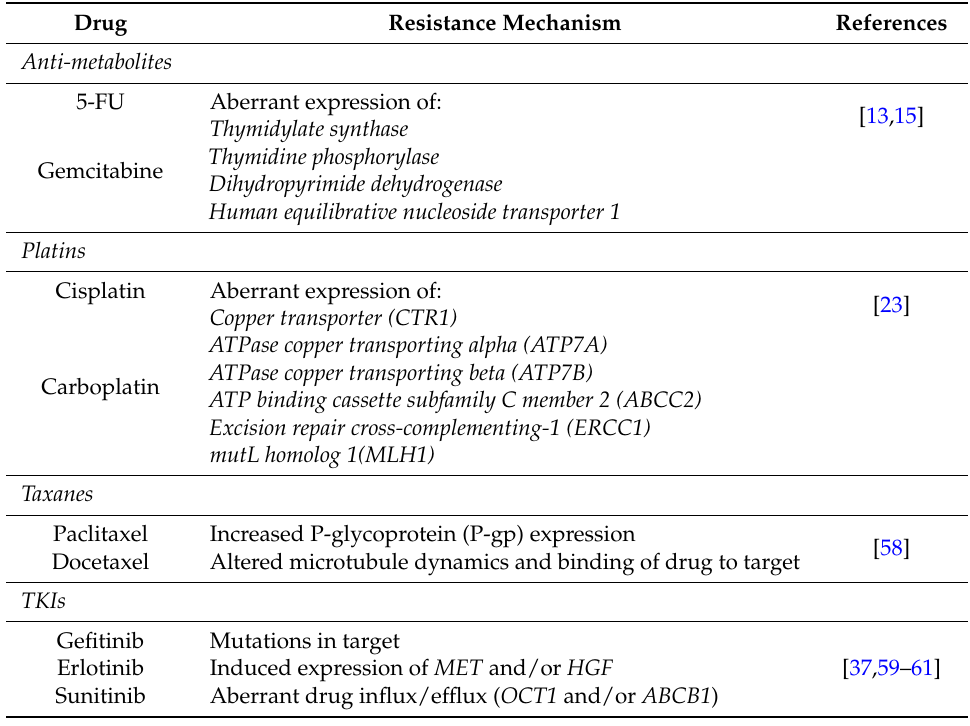
Table 1. Common resistance mechanisms observed with different chemotherapeutics. Molecular aberrations leading to resistance to the various classes of chemotherapeutics are classified as either influencing drug influx/efflux, metabolism, or mutations of